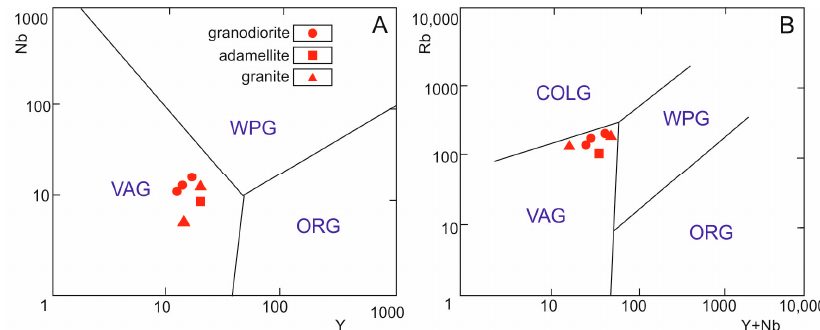
Figure 10. Discrimination ( A ) Nb–Y and ( B ) Rb–(Y + Nb) diagrams for Ergelyakh massif granitoids [56]. WPG, within-plate; VAG, volcanic island area; COLG, collisional; ORG, oceanic ridges.